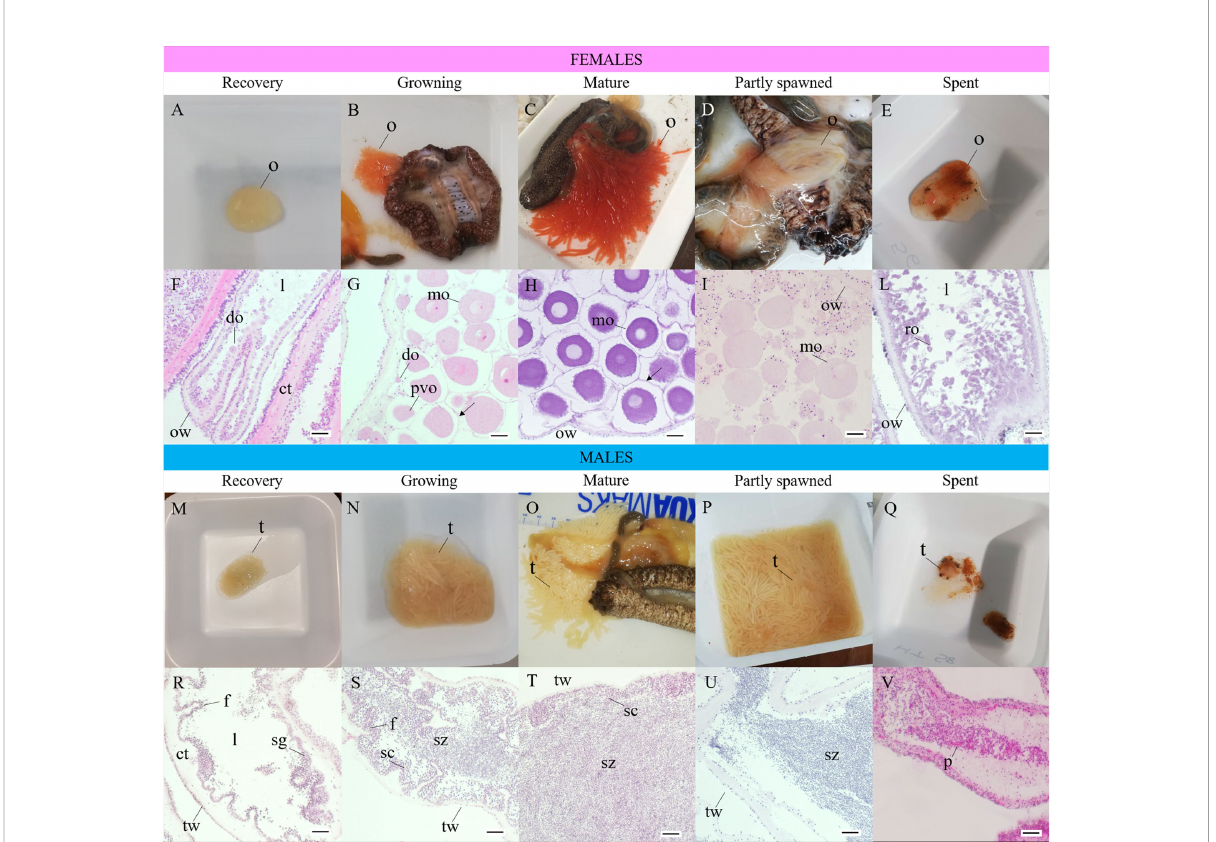
FIGURE 4 Macroscopic and histological maturity stages of Holothuria tubulosa females (A – L) and males (M – V) . (A) , ovary at recovery stage (GSI<2, observed in autumn and winter); (B) , female in growing stage (TL: 21.3 ± 1.2 s.d.; GSI: 4.0 ± 1.4 s.d.; observed in spring and summer); (C) , female in mature stage (TL: 22.8 ± 5.2 s.d.; GSI: 15.8 ± 8.2 s.d.; observed mainly in summer); (D) , female in partly spawned stage (TL: 20.1 ± 1.2 s.d.; GSI: 2.29 ± 2.1 s.d.; observed in summer and autumn); (E) , ovary in spent stage (GSI<1; observed in autumn and winter); (F) , longitudinal section of ovary in recovery stage with small developing oocytes arranged in a single layer, thick ovarian wall (E – H) ; (G) , ovary in growing stage with developing and mature oocytes arranged in multiple layers (E – H) ; (H) ovary in mature stage characterized by fully-grown mature oocytes densely packed; thin ovarian wall (AB/PAS); (I) , ovary in partly spawned stage with mature oocytes less abundant and empty spaces in the lumen (E – H) ; (L) ovary in spent stage with thick ovarian wall and unspawned relict oocytes (E – H) ; (M) , testis at recovery stage (GSI< 2, observed in winter); (N) , testis in growing stage (TL 20.6 ± 5.3 s.d., GSI 2.3 ± 2.1 s.d., observed in spring and summer); (O) , male in mature stage (TL 25.1 ± 5.5 s.d., month of sample GSI 8.5 ± 4.0 s.d. observed in spring and summer); (P) , testis in partly spawned stage (TL 17.3 ±